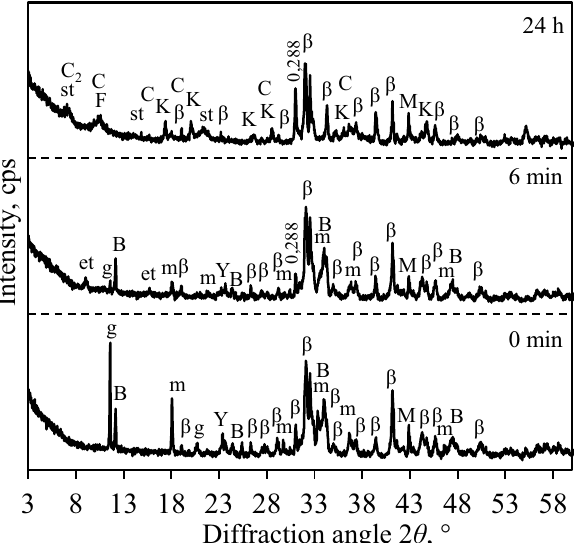
Figure 9. XRD patterns of S2-1100 sample after different durations of hydration. Indexes: m-mayenite, β-larnite (β-C